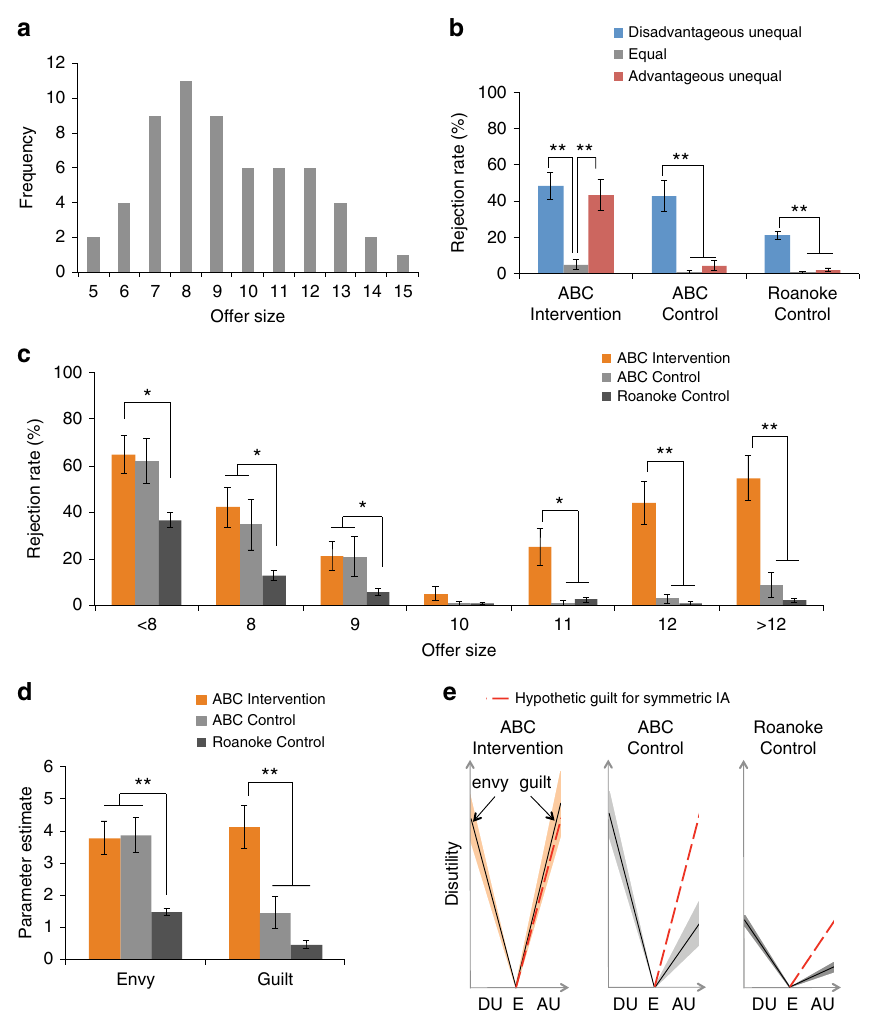
Fig. 2 Offer distribution, rejection rates, and model-based parameters in the ultimatum game. a Distribution of offer size for Medium-High-Medium (MHM) conditioning type. The frequency is the average occurrence for each offer size across participants in MHM. b Rejection rates for MHM grouped by level of equality. All groups had higher rejection rates for disadvantageous offers than equal offers. Advantageous offers were not rejected more than equal offers in ABC Control and Roanoke Control, while ABC Interventions rejected advantageous offers more than equal offers. c Rejection rates for MHM grouped by offer size. Only ABC Interventions increased rejection rates as a function of inequality, regardless of them being personally advantageous or disadvantageous, presenting a “ V shape ” pattern. d Parameter estimates from the behavioral modeling using a Fehr – Schmidt inequality aversion model. Both ABC Interventions and ABC Controls have a higher level of envy (unwillingness to accept unequal offers which are disadvantageous to the participant) than Roanoke Controls. The ABC Interventions had a higher guilt (unwillingness to accept unequal offers which are advantageous to the participant) than ABC Controls and Roanoke Controls. e The horizontal axis presents different levels of equality: DU disadvantageous unequal, E equal, AU advantageous unequal. The vertical axis presents the disutility de fi ned by the inequality aversion (IA) model (i.e., sensitivity × inequality). The slope of each line presents the sensitivity for inequality aversion (IA; envy for DU and guilt for AU). A steeper slope corresponds to higher inequality aversion. Compared with the control groups, ABC Interventions presented a much more symmetric IA pattern (i.e., the same level of envy and guilt). Shaded areas are bounded by mean ± s.e.m. * p < 0.05, ** p < 0.001 (post hoc t -test p -values). Error bar represents